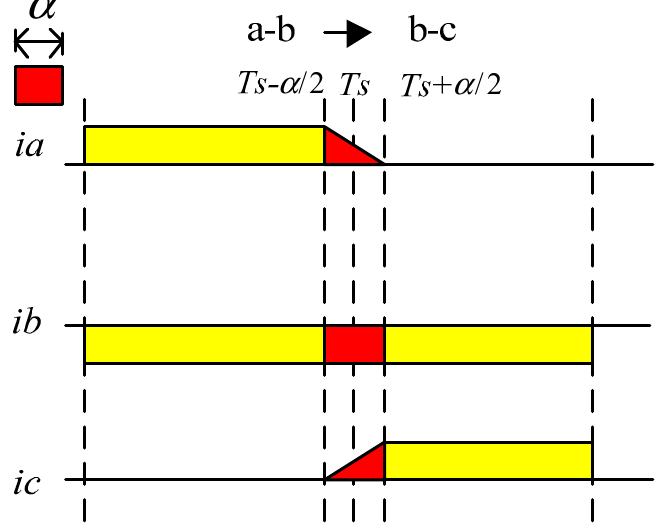
Figure 6. Phase commutation process with simultaneous three-phase conduction.